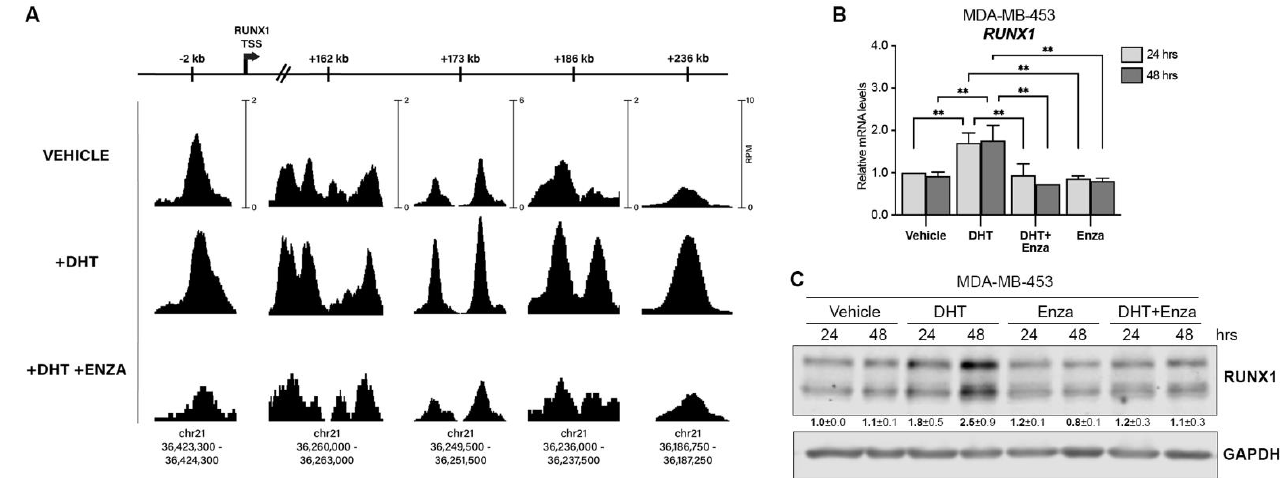
Figure 1. AR regulates RUNX1 expression. ( A ) MDA-MB-453 cells were treated with either vehicle (DMSO + ethanol), DHT (10 nM) or DHT + Enza (20 μ M) for 24 h. AR ChIP-seq was performed and the RUNX1 promoter and intronic regions were analyzed. The scale bars at the top are labeled for each locus to indicate the relative distance from the canonical RUNX1 transcription start site (TSS). The AR ChIP-seq signals are shown for each treatment condition at multiple loci within RUNX1. The scale at each position (shown in the ‘VEHICLE’ track) indicates the normalized range of signal values within that region (as measured by reads per million, RPM) and is the same for all treatment conditions to allow for accurate comparison of the peak intensities. The chromosomal coordinates of each peak are shown below. RUNX1 qPCR ( B ) and Western blot ( C ) were performed in MDA-MB-453 cells treated with either vehicle (DMSO + ethanol), DHT (10 nM), Enza (20 µ M), or both for 24 and 48 h. GAPDH was used as a housekeeping control. Two-way ANOVA followed by Tukey multiple comparison was performed in ( B ) from three independent experiments, ** p < 0.01. One representative experiment of three is shown in ( C ), mean ± SEM is